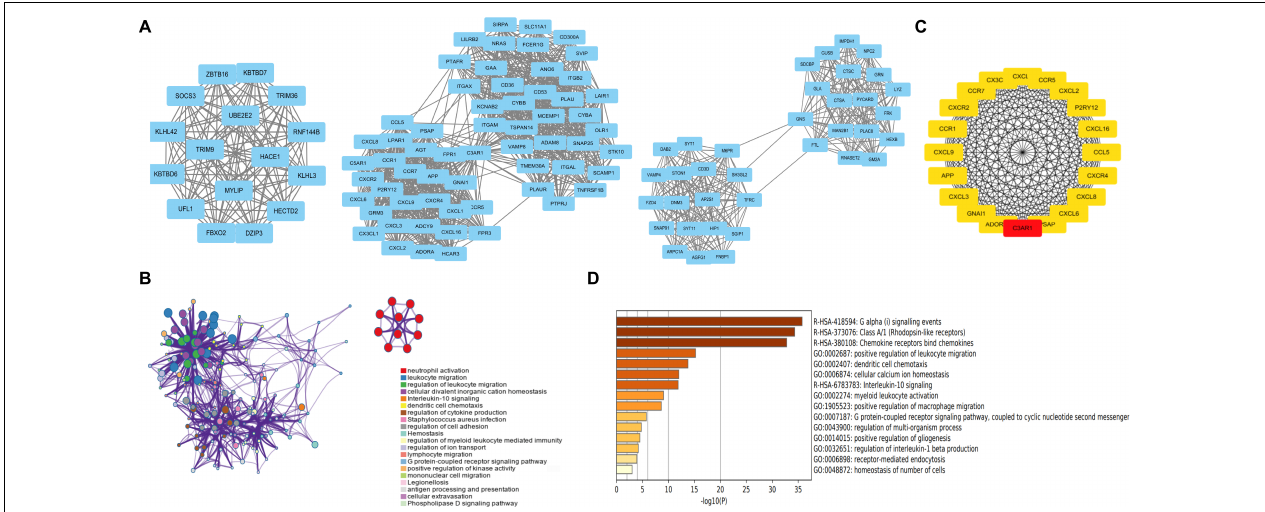
FIGURE 2 | PPI network and subnetwork construction and hub gene identification. (A) Six subnetworks of PPI using MCODE plug-in of Cytoscape. The first three clusters are displayed. (B) The most related subnetworks were related to immune infiltration, neutrophil activation, leukocyte movement, and ubiquitination. (C) Twenty hub genes were identified by an MCC algorithm. (D) The hub genes were significantly enriched in positive regulation of leukocyte migration, dendritic cell chemotaxis, and positive regulation of macrophage migration. PPI, protein–protein interaction.